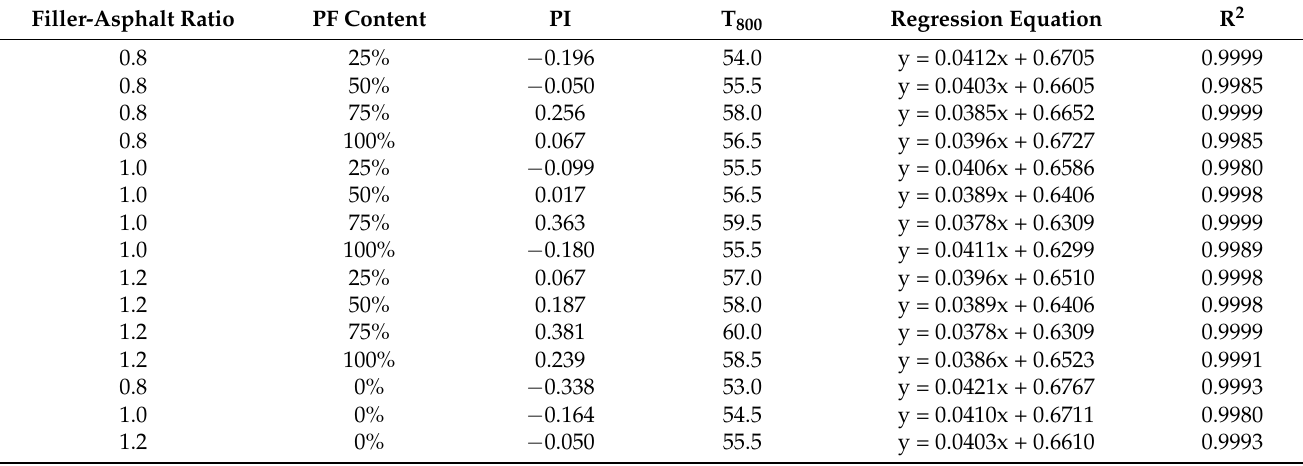
Table 7. Results of PI and